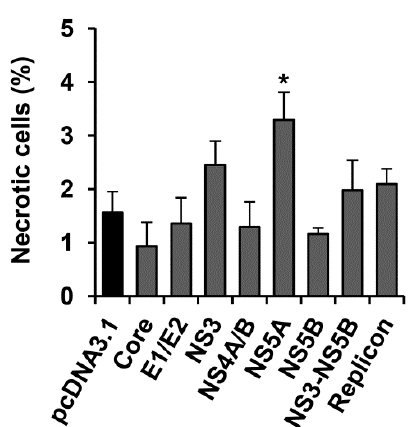
Figure 5. HCV NS5A protein promotes necrotic cell death. Huh7.5 cells harboring the HCV replicon, or transfected with the HCV-expressing plasmid or the empty pcDNA3.1(+) vector were stained 72 h posttransfection with trypan blue, and the stained cells were counted. The bars represent percentages of trypan-positive cells. Values are means ± SEM from three independent experiments, * p < 0.05 compared to the cells transfected with the empty vector (black bar).